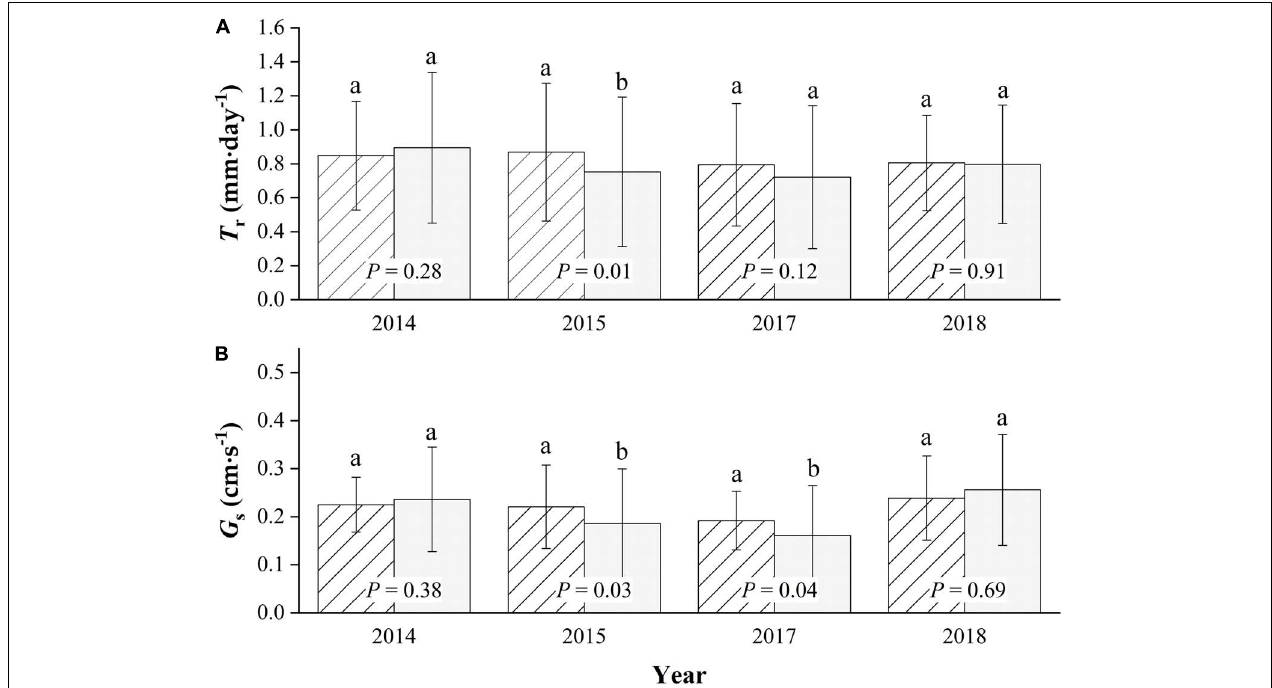
FIGURE 4 | Seasonal comparison of average daily canopy transpiration, T r (A) , and canopy conductance, G s (B) for Mongolian Scots pine ( MP ) and Chinese pine ( CP ) in the 4 years of xylem sap flux measurement. Different lowercase letters represented significant differences at α = 0.05 level.